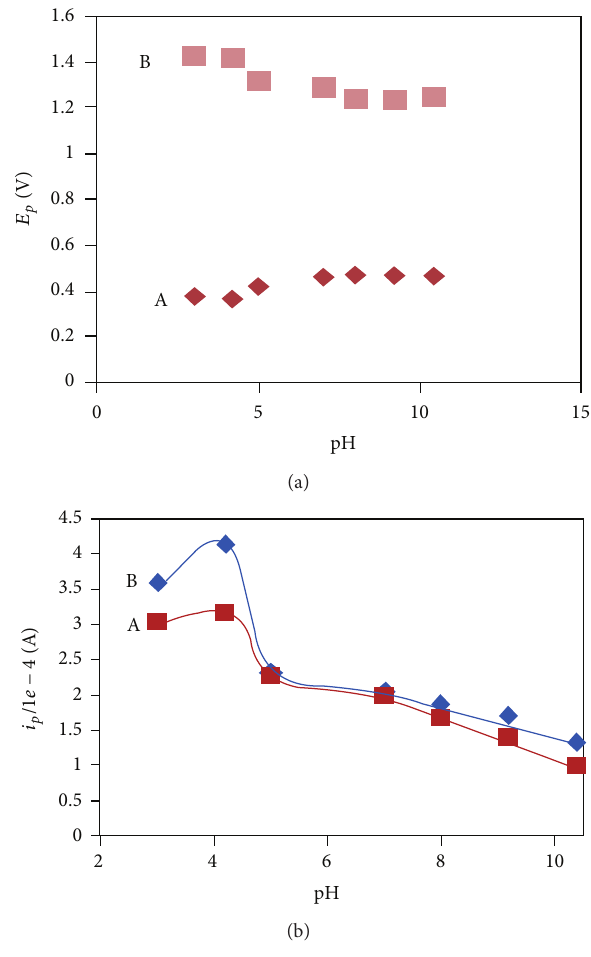
Figure 3: (a) Influence of pH on the peak potential of 2-thiouracil for peaks A and B. (b) Variation of peak currents of peaks A and B with